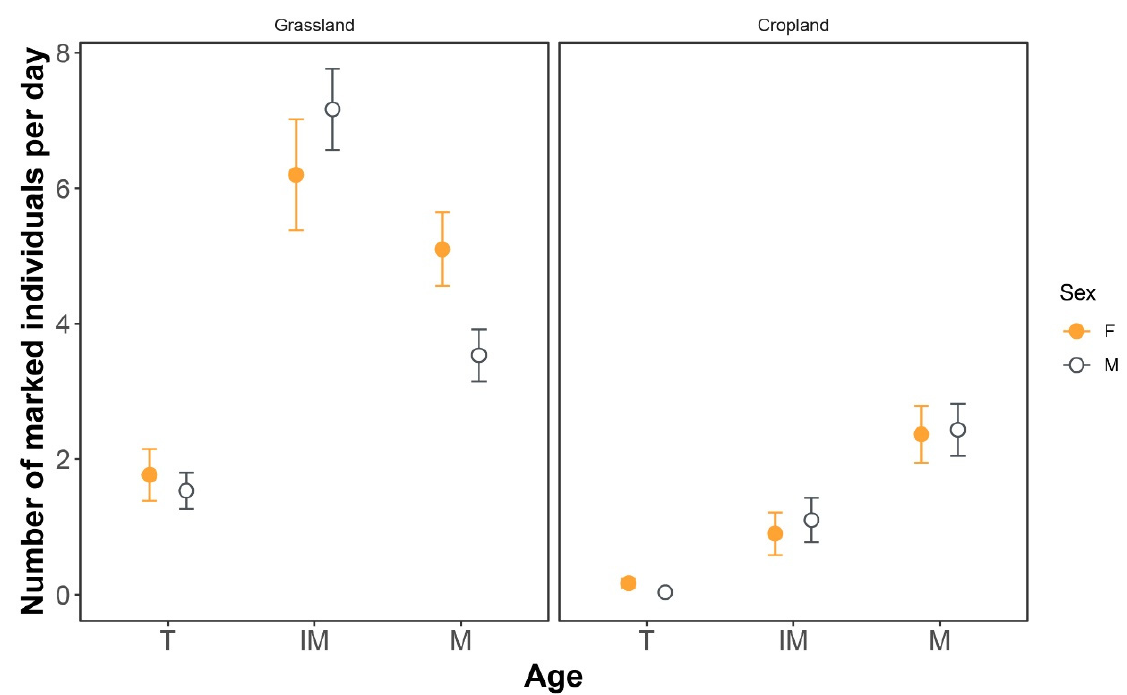
Figure 3. Average number of marked individuals per day of Platycnemis subdilatata across three age classes and sexes in grassland and cropland in northeastern Algeria. Grassland (3–5 m away from the water) was closer to the water than cropland. Error bars are 95% confidence intervals. T: teneral; IM: immature; M: mature individuals. Table 1. Summary statistics of the negative binomial model assessing the effect of age class, land-type and sex on the number of marked adult individuals of Platycnemis subdilatata per day. Baseline level for contrast calculation for age was immature individuals (IM), for sex was female, and for land was cropland. Estimate Std. Error